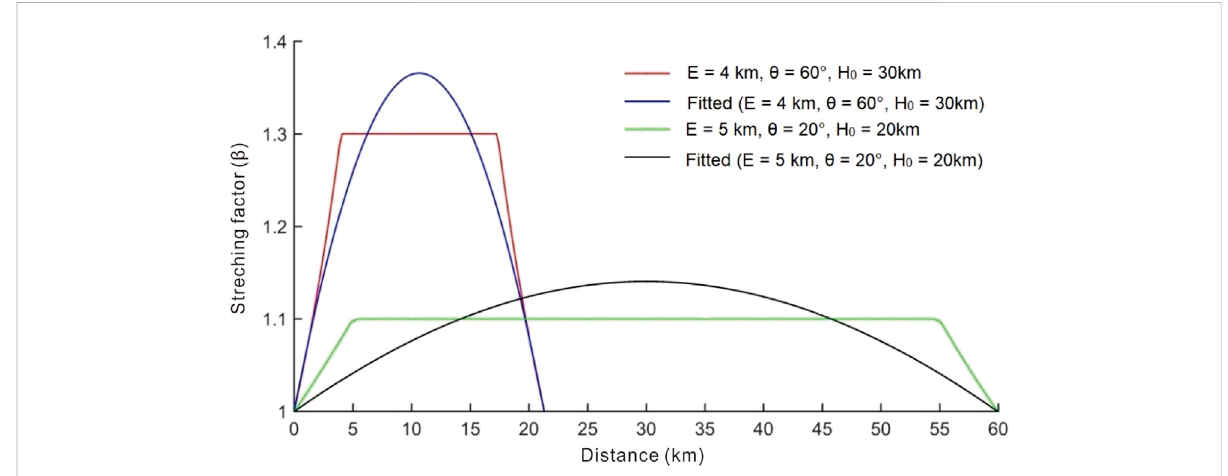
FIGURE 6 Two β pro fi les generated by Eq. 9 under thegiven oftwo parameter sets are shown inred and green, respectively. The best fi t β curvesby Eq. 11 with the corresponding parameter sets are presented in blue and black.